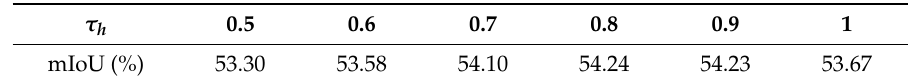
Table 4. Influence of τ h . The hyper-parameter τ h influences quality of GrabCut C . τ h = 1 means no positive foreground for GrabCut proposals.